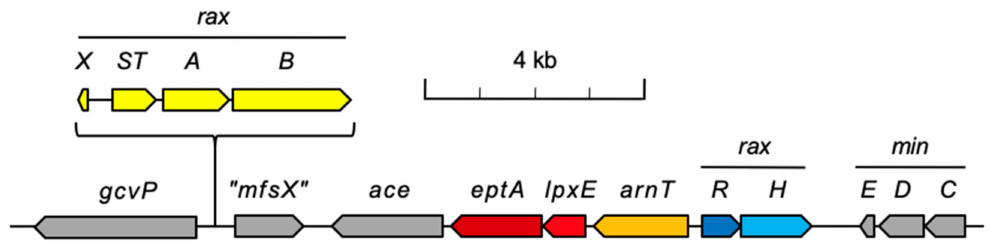
Figure 1. Genes in the Xoo strain PXO99 A gcvP-minCDE region. Drawn to scale. Gene symbols are eptA , phospho- ethanolamine transferase (dark red); lpxE , lipid A 1-phosphatase (red); arnT , sugar-undecaprenyl phosphate transferase (orange); raxR (dark blue); raxH (light blue). Other gene symbols are described in the text. The raxX-raxSTAB gene cluster is between gcvP and “ mfxS ” only in certain Xanthomonas species (Table S1). Small open reading frames with unknown function are not shown. See text for